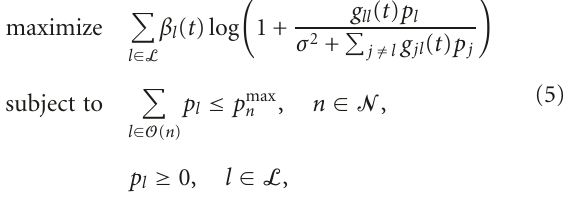
Algorithm 2 (RA via signomial programming ( A = ∅